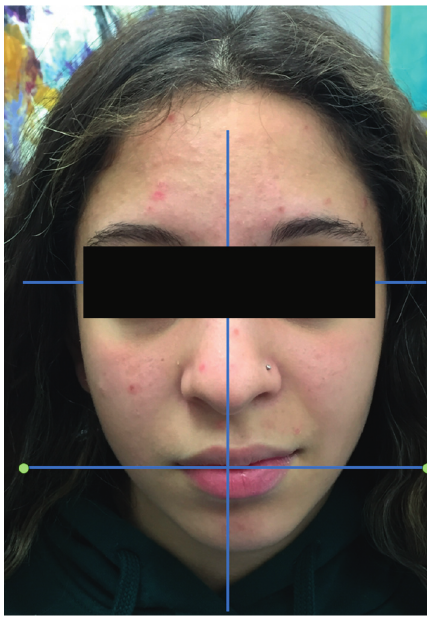
Figure 2: One week treatment follow-up.